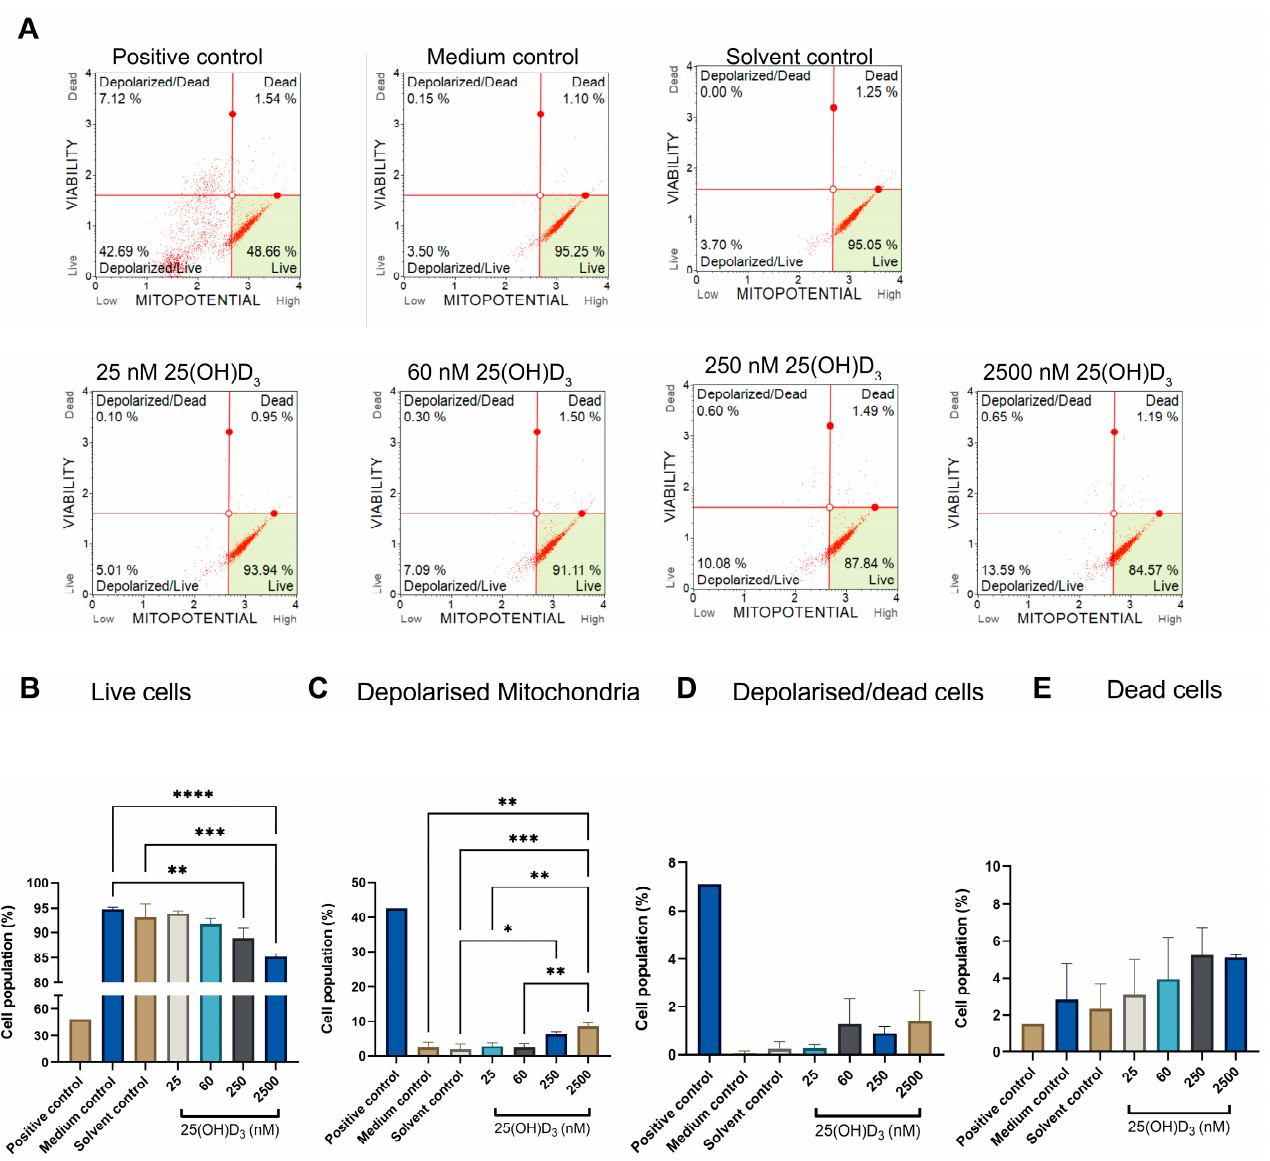
Figure 3. The effect of 25(OH)D3 on mitochondrial transmembrane potential ( ∆Ψ m) in SiHa cells was assessed by flow cytometry. Each dot plot of SiHa cells is divided into four stages: live, depo- larised/live, depolarised/dead, and dead cell populations ( A ). Analysis of the changes in ∆Ψ m across the four stages of mitochondrial depolarisation is represented by bar graphs ( B – E ). The positive control was treated with actinomycin to a final concentration of 0.1 μ g/mL. Data are expressed as mean (±SEM) from three independent experiments, each performed in triplicate (* p ≤ 0.05; ** p ≤ 0.01; *** p ≤ 0.001, **** p ≤ 0.0001).